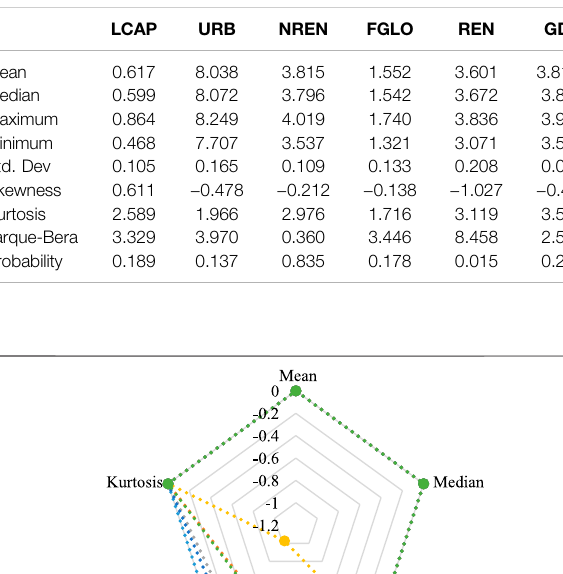
TABLE 2 | Descriptive statistics.